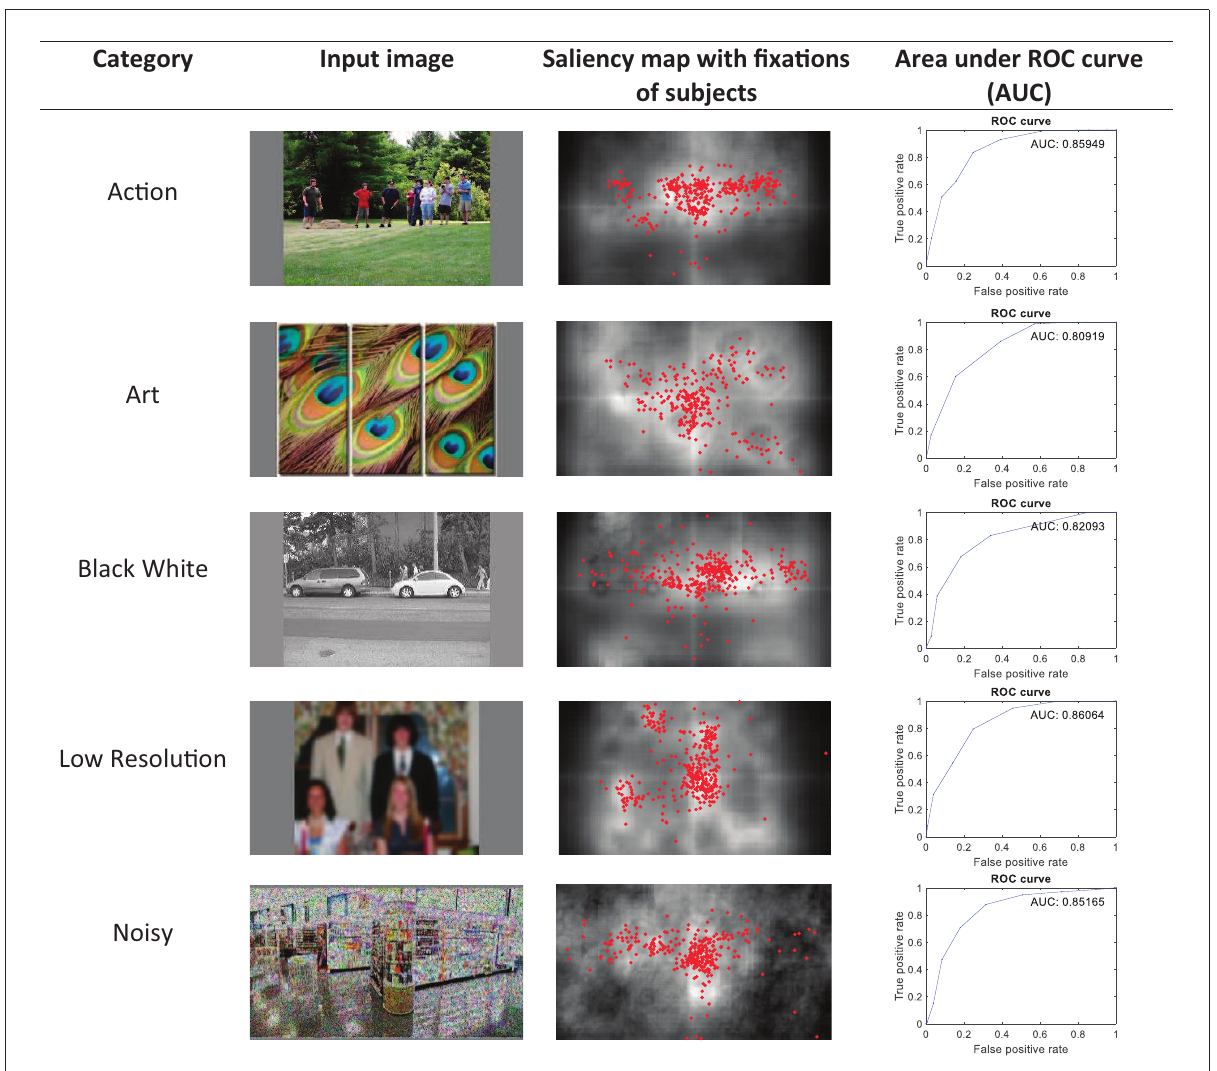
FIGURE2 Saliency map results and the AUC scores of the model for sample images of the CAT2000 dataset from various categories of Action, Art, Black White, Low Resolution, and